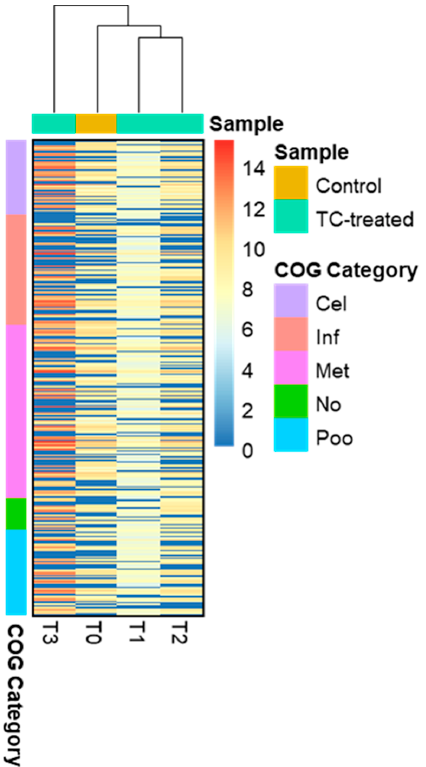
Figure 6. Heatmap presenting differentially expressed proteins. The proteins in the heatmap analysis were clustered according to five COG functional groups; Cel (Cellular process and signaling), Inf (Information storage and processing), Met (Metabolism), No (No COG annotation), and Poo (Poorly characterized).